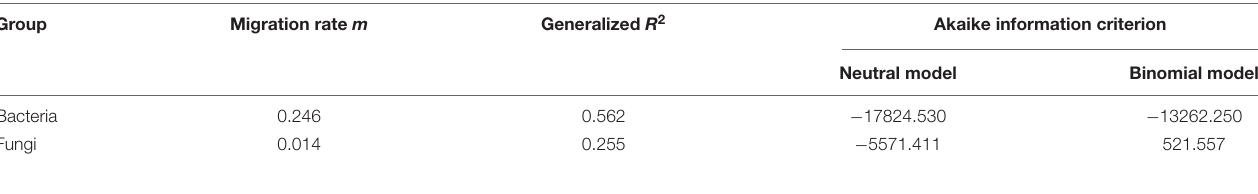
TABLE 1 | Fit of the neutral model and comparison with binomial